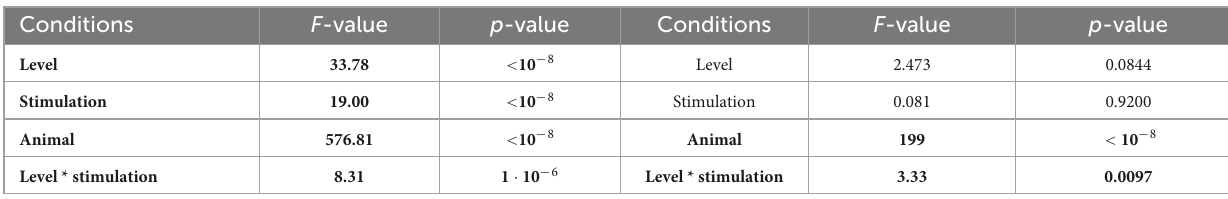
TABLE 1 Identification of significant